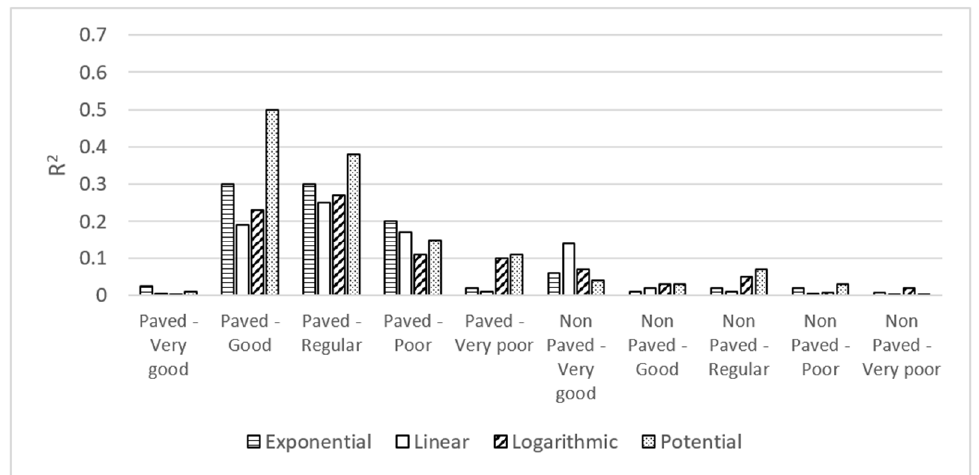
Figure 3. The R 2 value for regressions between departmental GDP for the agriculture, livestock, silviculture, hunting, fishing, and mining sectors, and roadway network length according to condition.